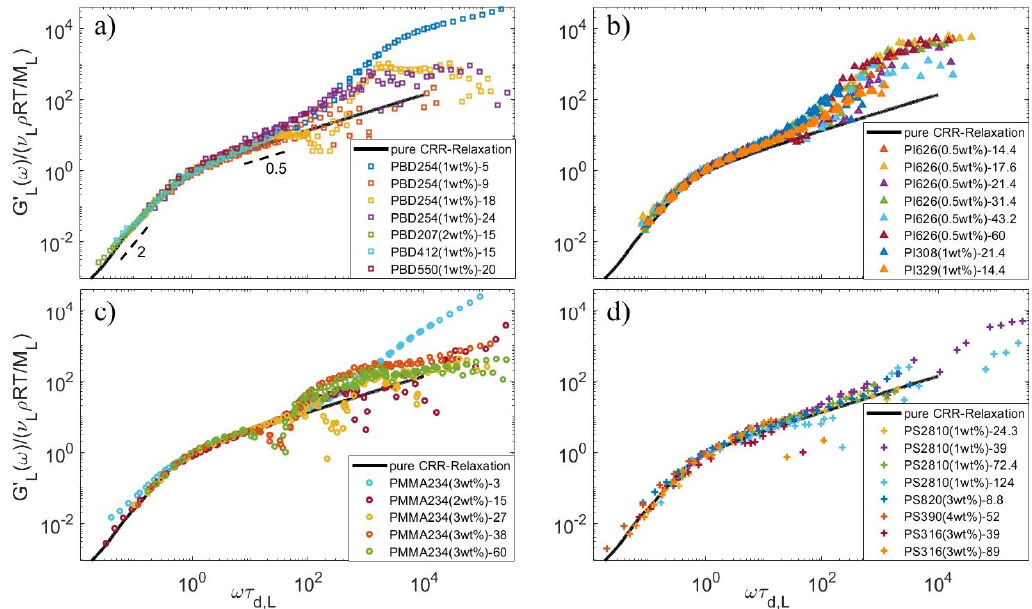
Figure 5. Normalized long chain storage modulus data of all available datasets under iso- T g condi- tions for ( a ) PBD, ( b ) PI, ( c ) PMMA, and ( d ) PS blends, compared to the expected storage modulus for a long polymer relaxing by a Rouse-like relaxation (black